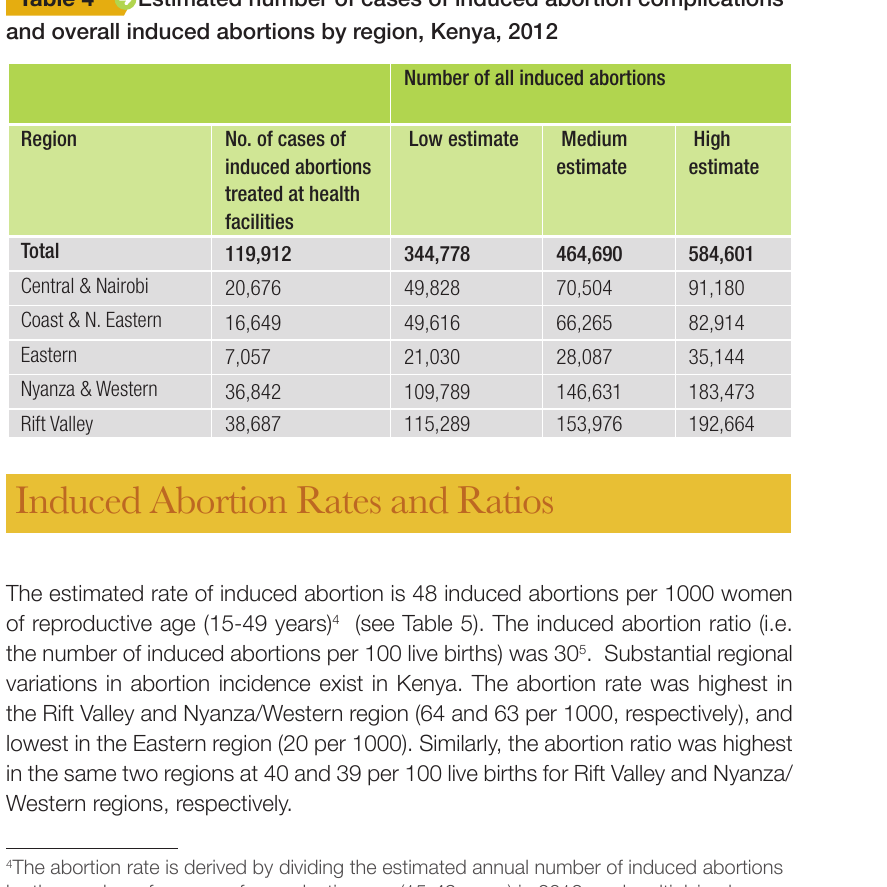
Estimated number of cases of induced abortion